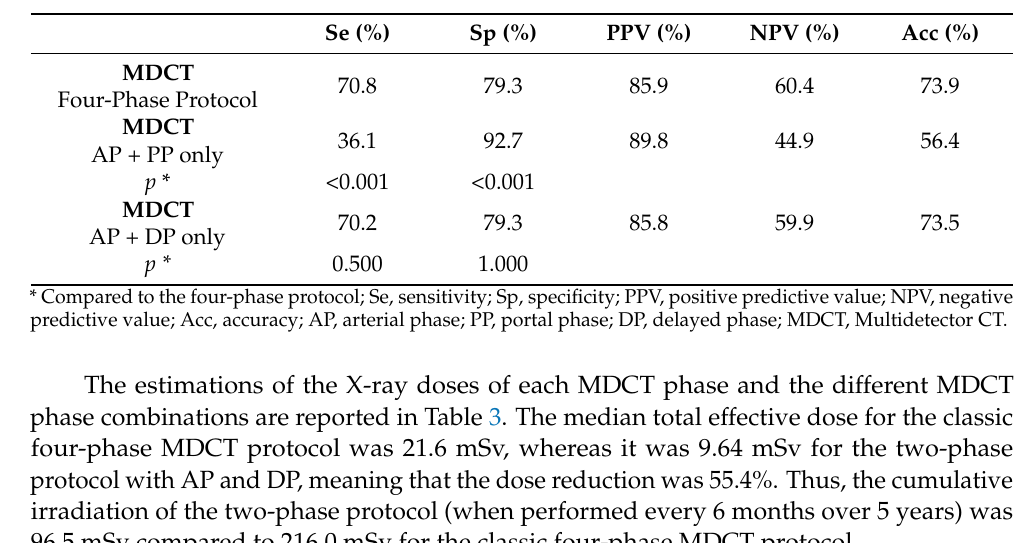
Table 2. The performance of the different combinations of dynamic phases for the diagnosis of